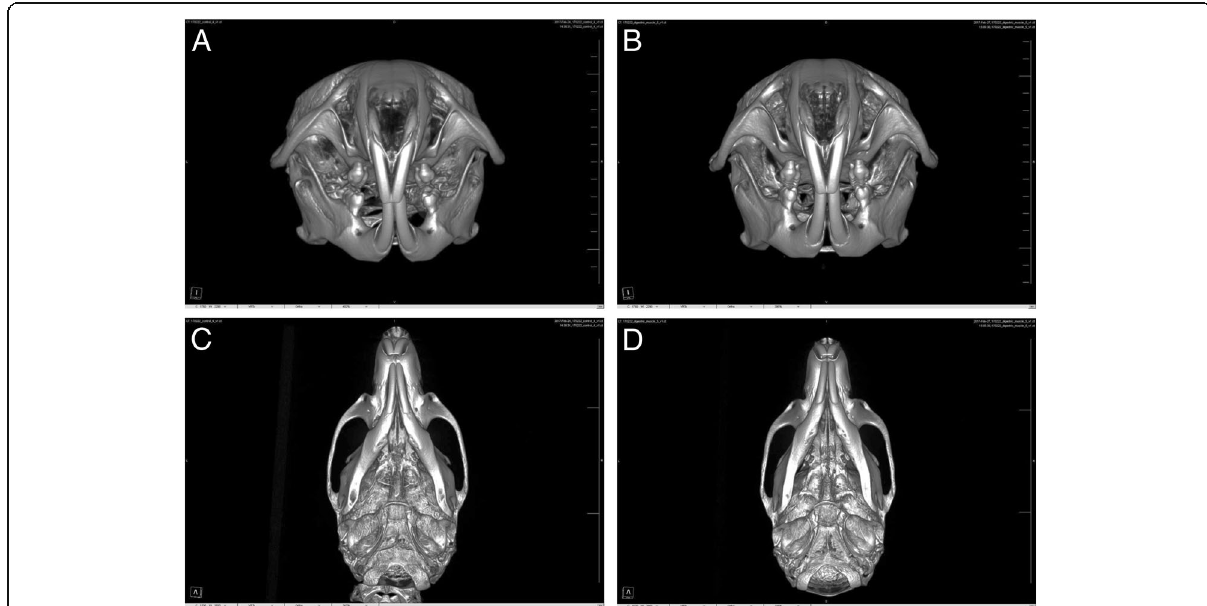
Fig. 3 μ CT images after the injection of saline for the control group and BTX for the experimental group. Axial view of the control ( a ) and experimental ( b ) groups. Coronal view of the control ( c ) and experimental ( d )